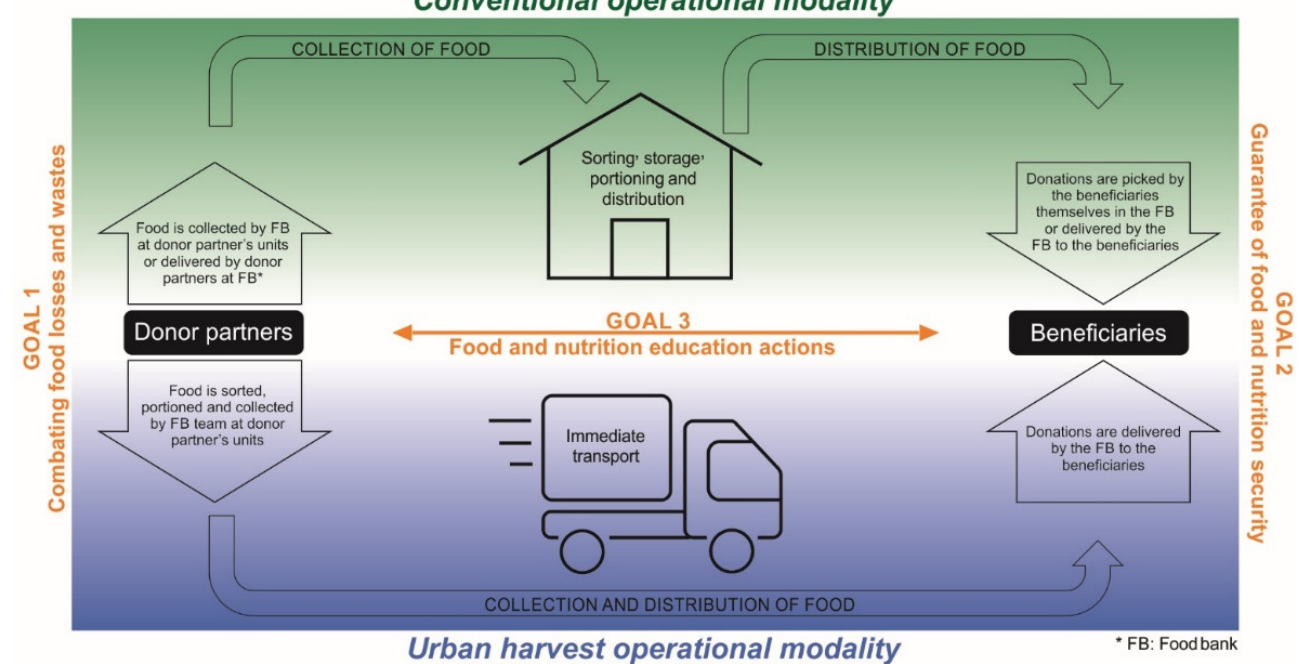
Figure 1. Operational logic of the Brazilian food banks and their relationship with the three fundamental goals.